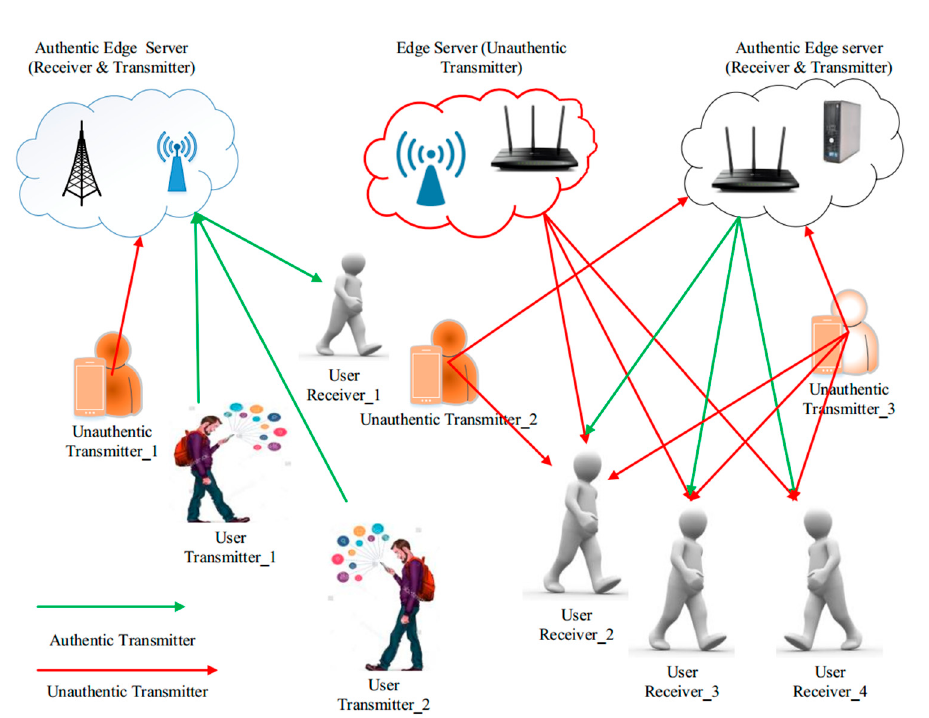
Figure 1. IAD between MEC servers and mobile users to detect authentic and unauthentic transmit-